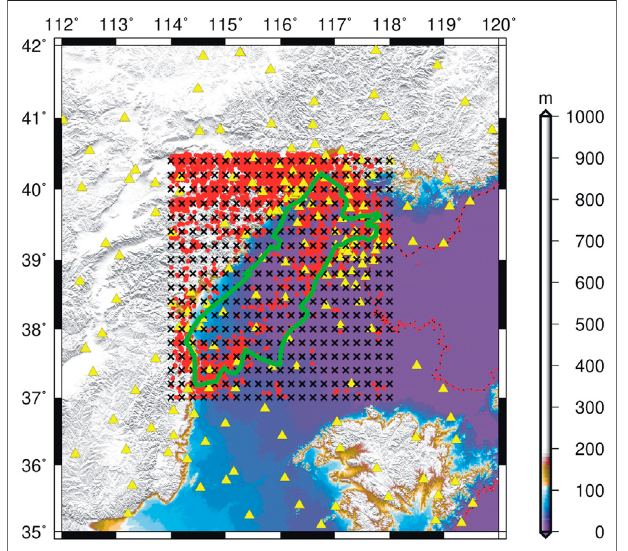
FIGURE2| Seismicevents(reddots)andstations(yellowtriangles).Grid points of 0.2 ° (black oblique cross) and the green frame (Jizhong depression).